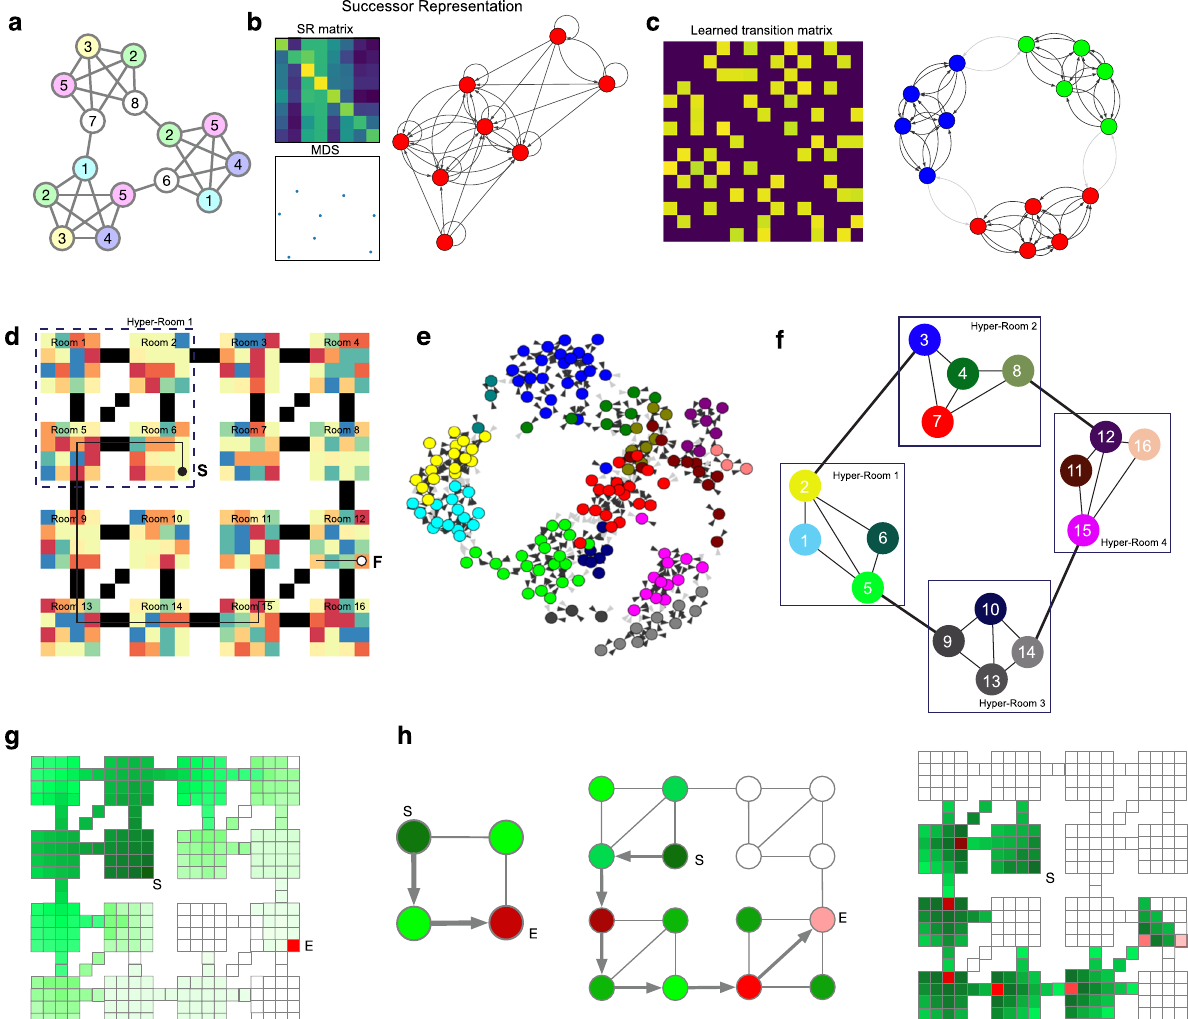
Fig. 7 CSCGs enable hierarchical abstraction and planning. The cloned graph of the CSCG lifts the observations into a hidden space, allowing for discovery of modularity that is not apparent in the visible observations. a The modular graph from 8 , modi fi ed to have aliased observations. Observations at each node are indicated by the numbers, and many different nodes produce the same observation. b MDS or community detection on the SR matrix of random walks in a does not reveal the modularity of the graph. c Community detection on the CSCG transition matrix successfully recovers the modularity of graph in a , recovering three communities. d A maze that has an embedded three-level hierarchy. Sensory observations are aliased both within rooms and across rooms. The black pixels denote “ bridges ” between the rooms. CSCG is trained on random walks from this maze. Community detection on the learned CSCG transition matrix revealed a fi rst level of organization into rooms ( e ), and another level of community detection revealed hyper-rooms ( f ), resulting in a three-level hierarchical graph re fl ecting the nested structure of the maze. Planning a path (black arrows) between two rooms (denoted as (S) tart ( fi lled black dot) and (F)inish (open black dot) in d ) was achieved by fi nding the shortest path between hyper-rooms to navigate, next fi nding the shortest path between rooms, and lastly fi nding the shortest path within the rooms in this reduced search space. g Visualization of planning message propagation in the one-level graph. Messages propagate in the whole maze, indicating a wide search area. h Visualization of hierarchical planning. Routes are fi rst identi fi ed on the highest level, which then becomes sub-goals at the lower level. The red colored nodes indicate the sequence of sub-goals, and their intensities re fl ect the ordering of the sub-goals. Compared to g , hierarchical planning requires fewer messages to be propagated so it is